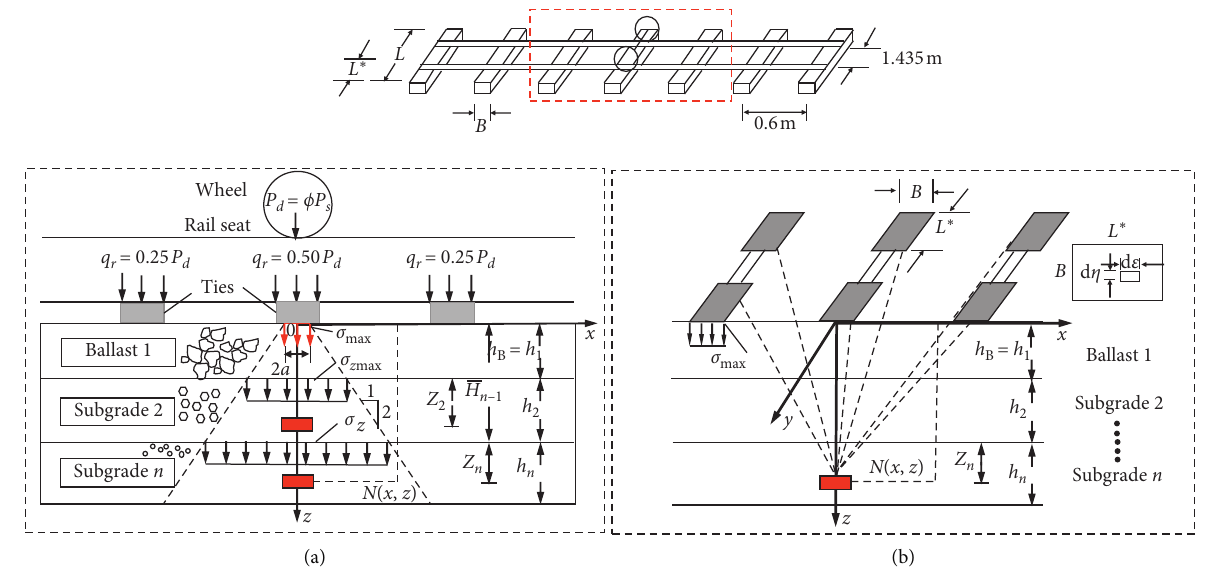
Figure 1: Schematic layout of a typical railway track system: (a) the trapezoidal method; (b) The Boussinesq method.